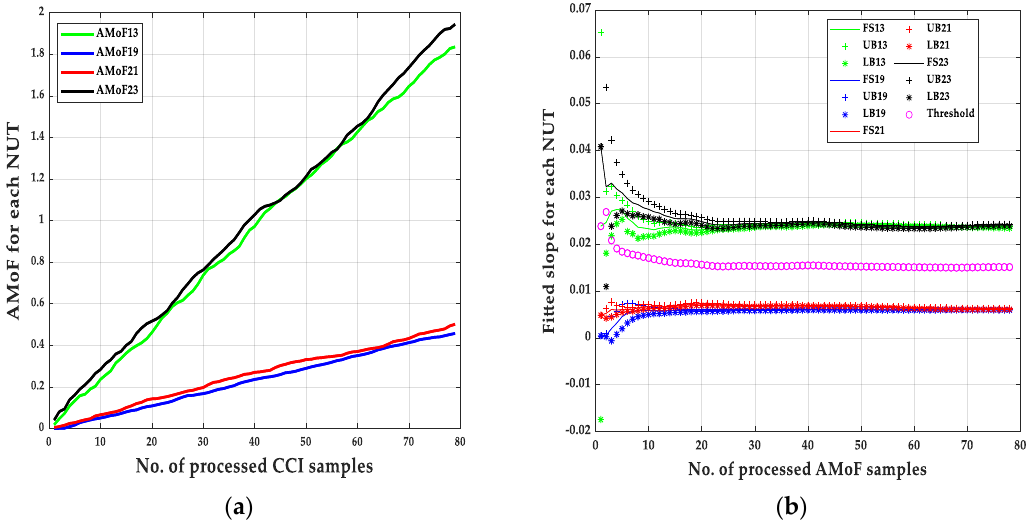
Figure 3. The AMoF and the fitted slope for different nodes for scenario NS15P7: ( a ) The AMoF for different NUT; ( b ) the fitted slope for NS15P7_FL_RWP 25/5. Table 3. Performance characterization for NS15P7_FL_RWP 25/5.